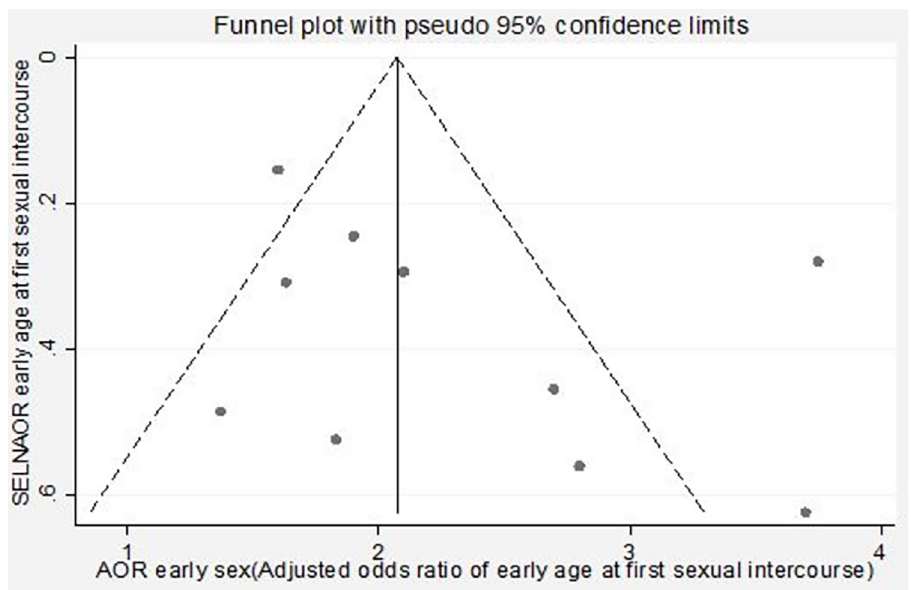
Fig 2. Funnel plot showing publication bias (inverted symmetrical funnel plot), March